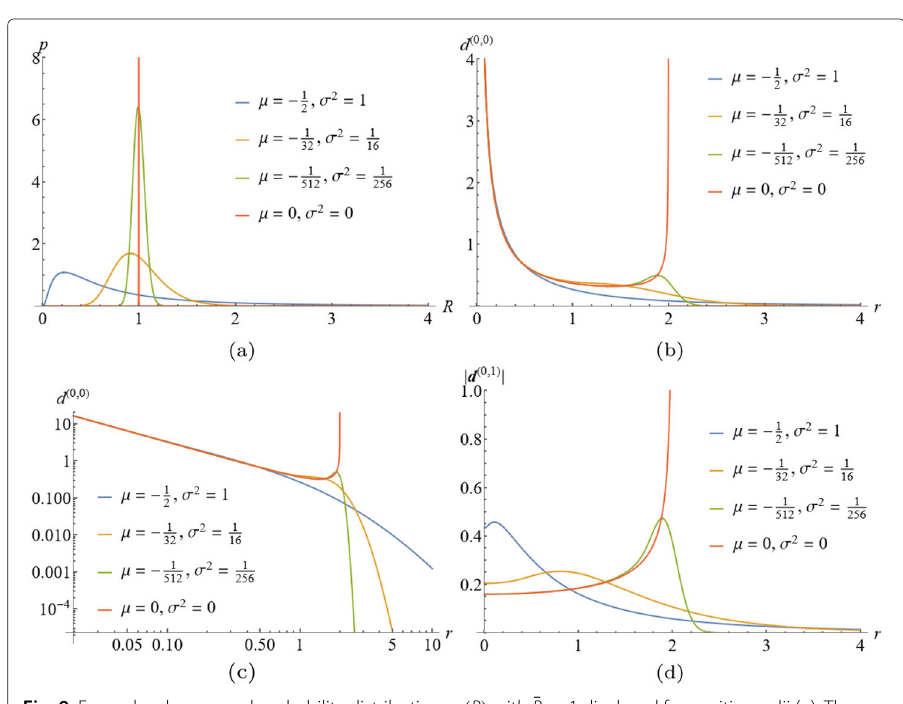
Fig. 9 Exemplary log-normal probability distributions p ( R ) with ¯ R = 1 displayed for positive radii ( a ). The scalar correlation function d ( 0,0 ) as a function of r with linear ( b ) and double logarithmic ( c ) scales, as obtained from Eq. (93) with the distribution functions shown in ( a ). Modulus of the correlation vector field d ( 0,1 ) in dependence on r ( d ), as obtained from Eq. (93) with the distribution functions shown in ( a